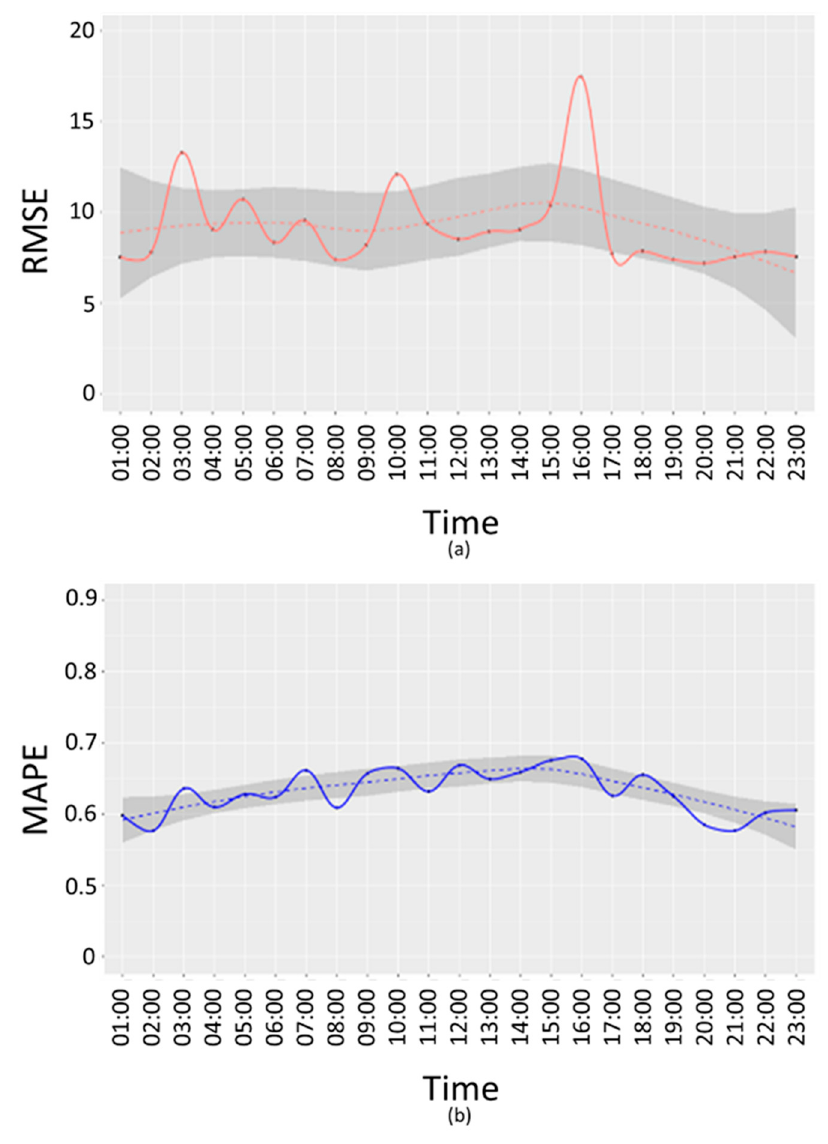
Figure 9. 𝑃𝑀 (cid:2869)(cid:2868) working days RMSE ( a ) and MAPE ( b ) per time slots (IDW Method). Figure 9. PM 10 working days RMSE ( a ) and MAPE ( b ) per time slots (IDW